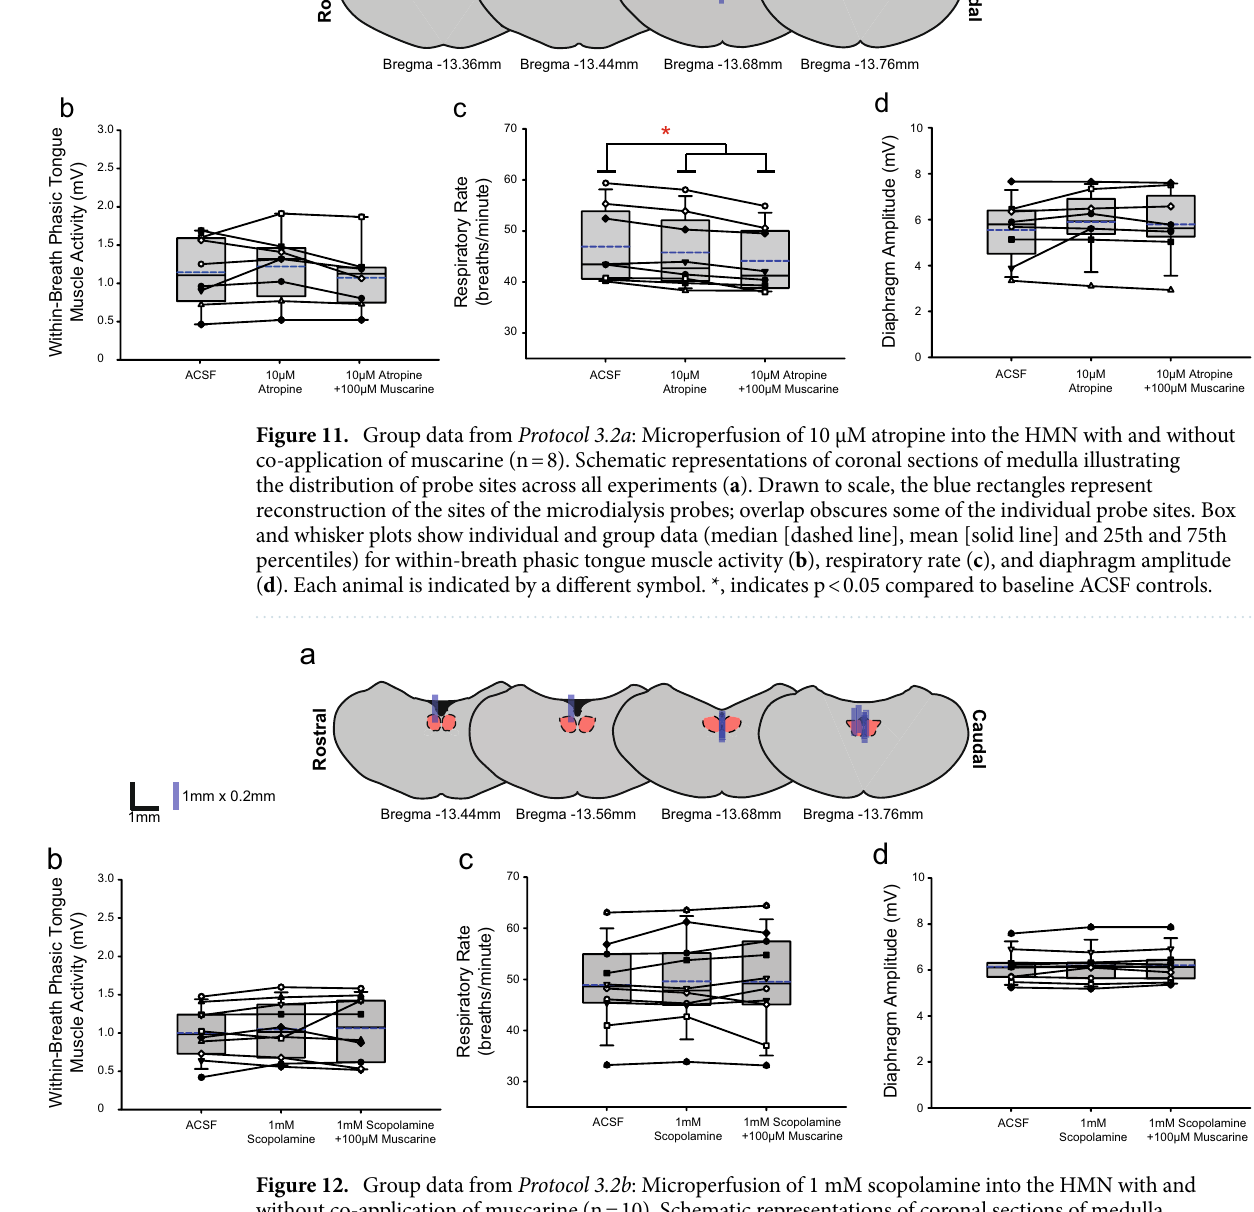
Figure 12. Group data from Protocol 3.2b : Microperfusion of 1 mM scopolamine into the HMN with and without co-application of muscarine (n = 10). Schematic representations of coronal sections of medulla illustrating the distribution of probe sites across all experiments ( a ). Drawn to scale, the blue rectangles represent reconstruction of the sites of the microdialysis probes; overlap obscures some of the individual probe sites. Box and whisker plots show individual and group data (median [dashed line], mean [solid line] and 25th and 75th percentiles) for within-breath phasic tongue muscle activity ( b ), respiratory rate ( c ), and diaphragm amplitude ( d ). Each animal is indicated by a different symbol. *, indicates p < 0.05 compared to baseline ACSF